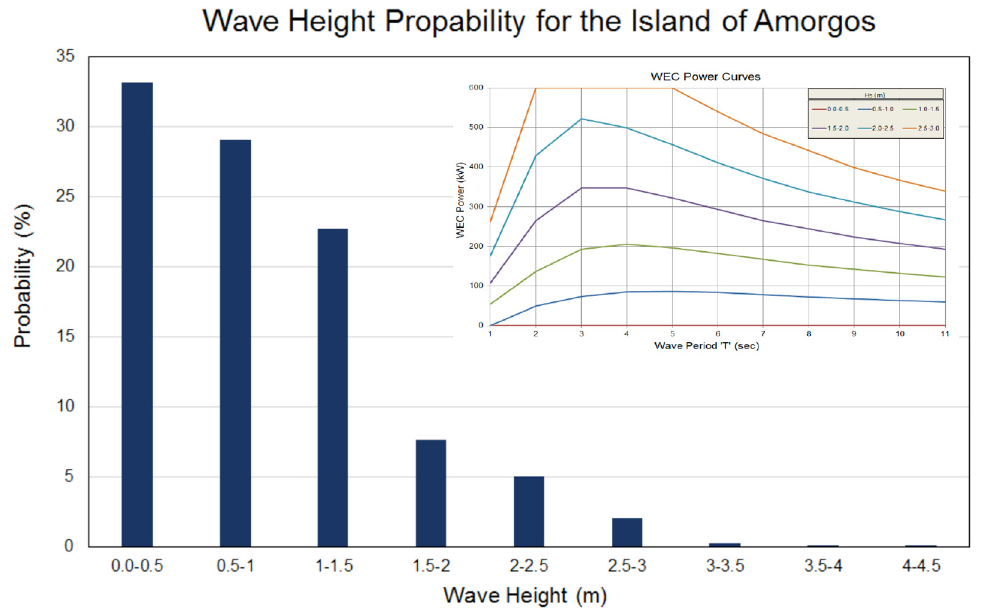
Fig. 2. Wave potential characteristics vs. wave converter power